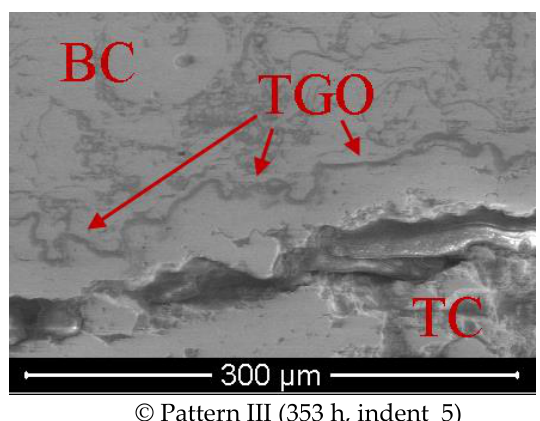
Figure 4. Crack formation patterns, depending on the aging time. TGO: thermally-grown oxide.